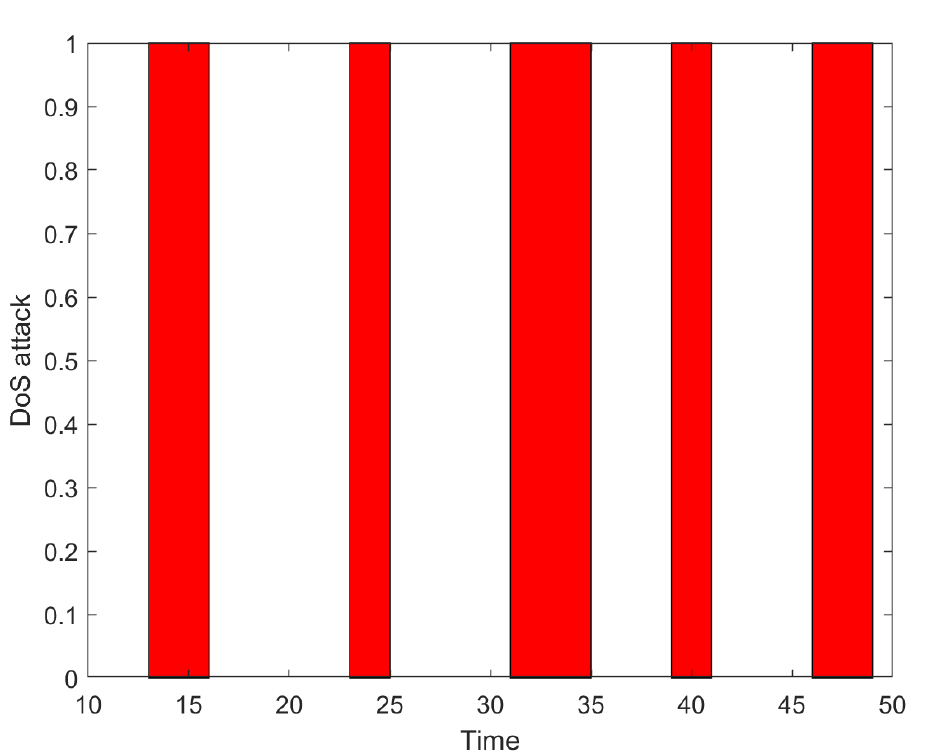
Figure 6. DoS attack sequence